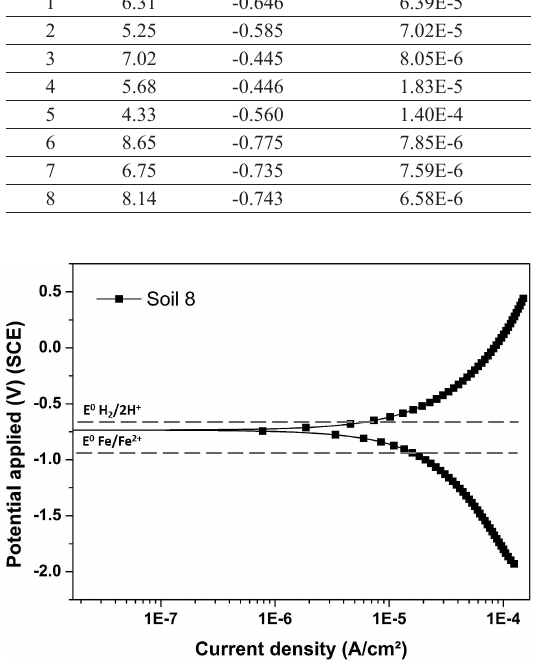
Figure 6. Polarization curves for soil 8 and its derivations with 3.5% (wt.) NaCl (MS1), with 5% (wt.) cement (MS2) and with 3.5% (wt.) NaCl + 5% (wt.) cement